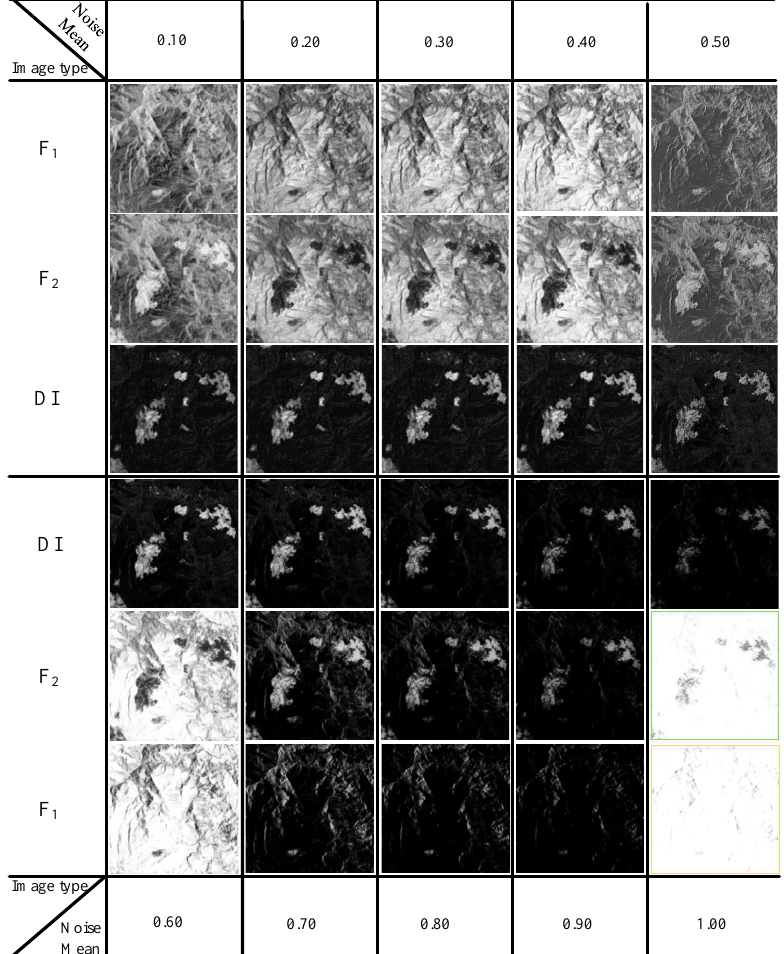
Figure A3. The F 1 , F 2 and DI with different mean levels of Gaussian noise (Variance: 0.01) on the Mexico data